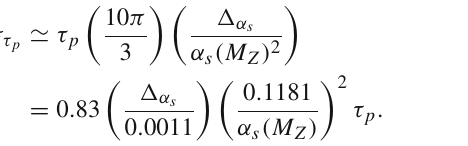
where (cid:20) α is the 1- σ uncertainty in α s and we have assumed s is dominantly determined by g 3 . that the variation of M H C This then